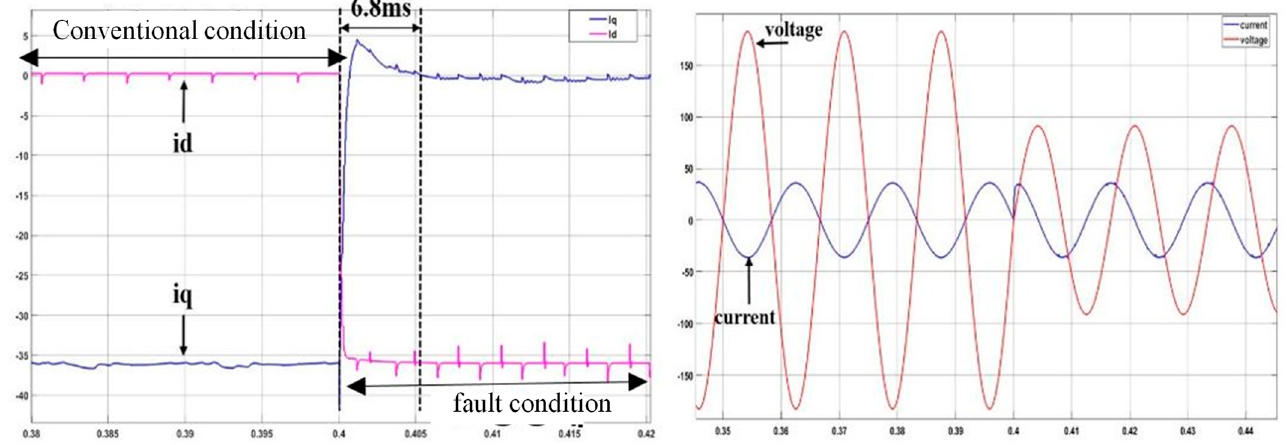
Figure 29. Response results of the proposed grid-connected devices depending on grid voltages.